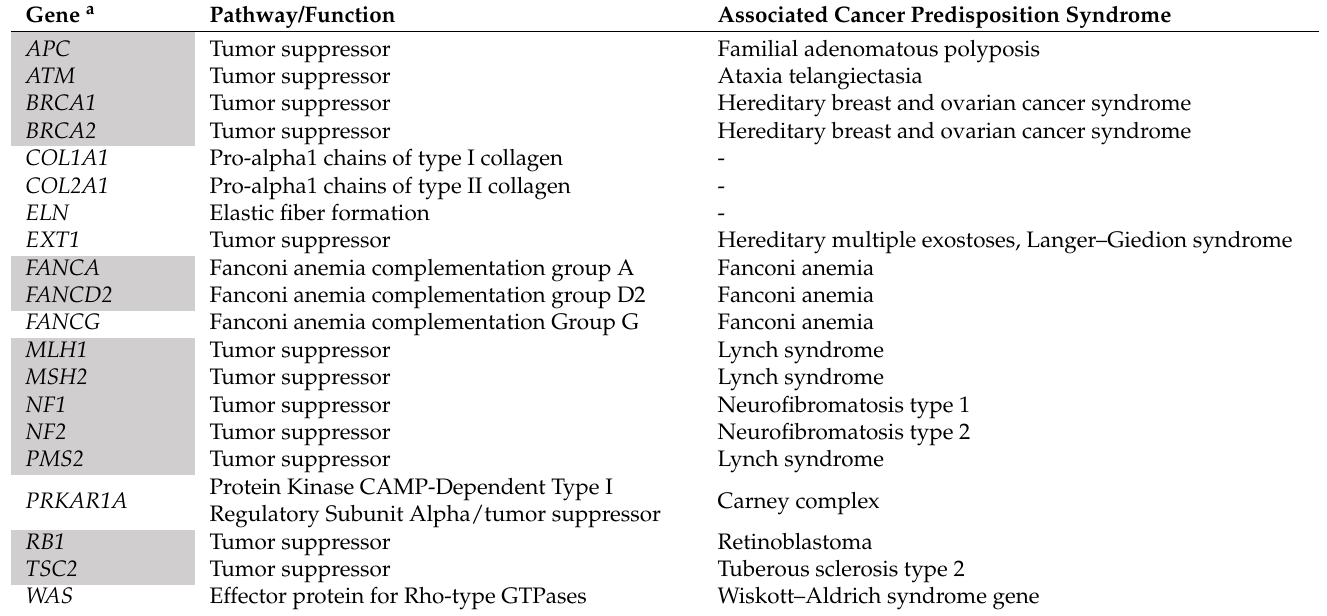
Table 1. Cancer-related genes enriched in splicing